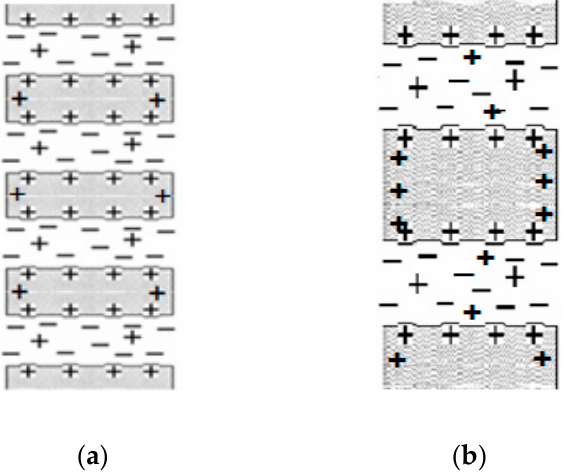
Figure 2. Scheme of ion transport through two positively charged nanoporous membranes with the same thickness and material but different pore size and porosity. ( a ) Pore charge practically rejects all co-ion favoring counter-ion transport in membranes with reduced pore radii; ( b ) higher pore size favors co-ion inclusion, increasing co-ion transport number.